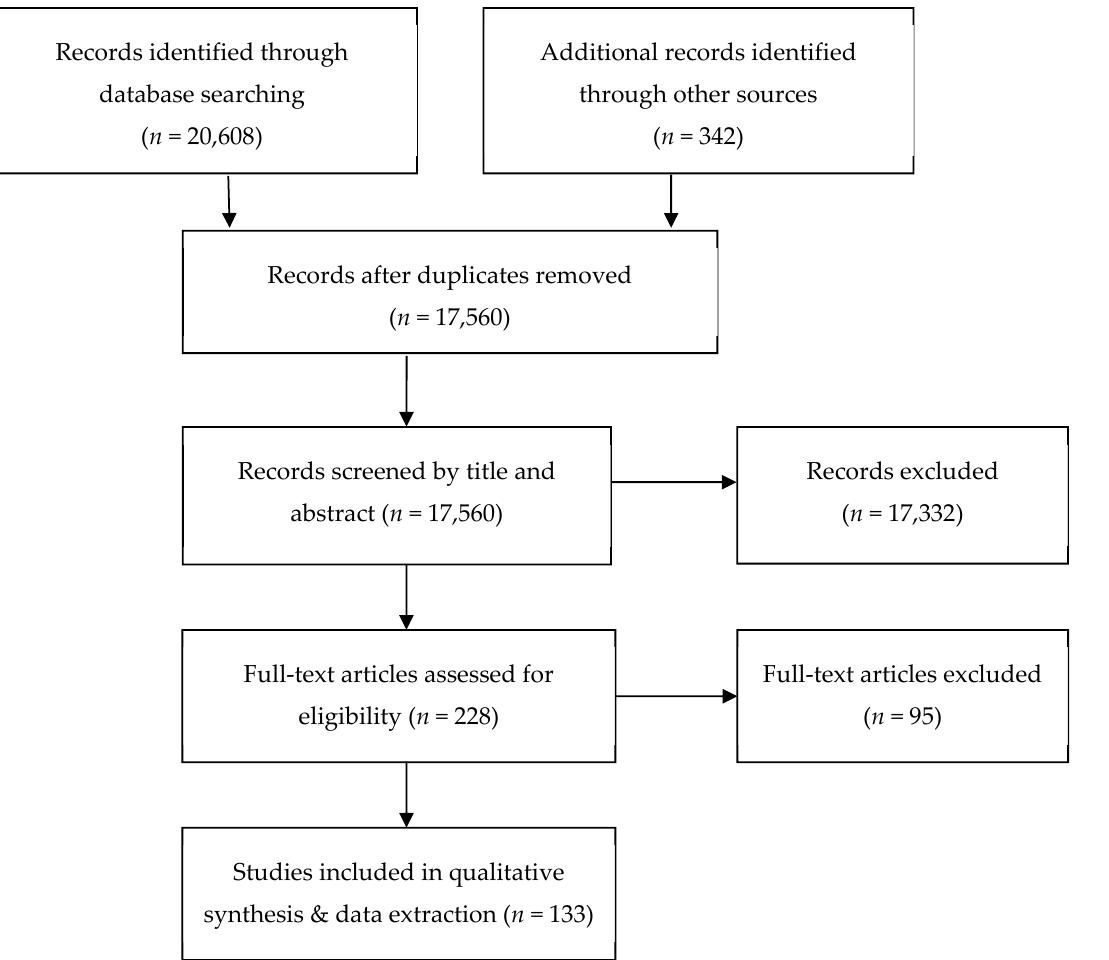
Figure 1. Research and selection process.